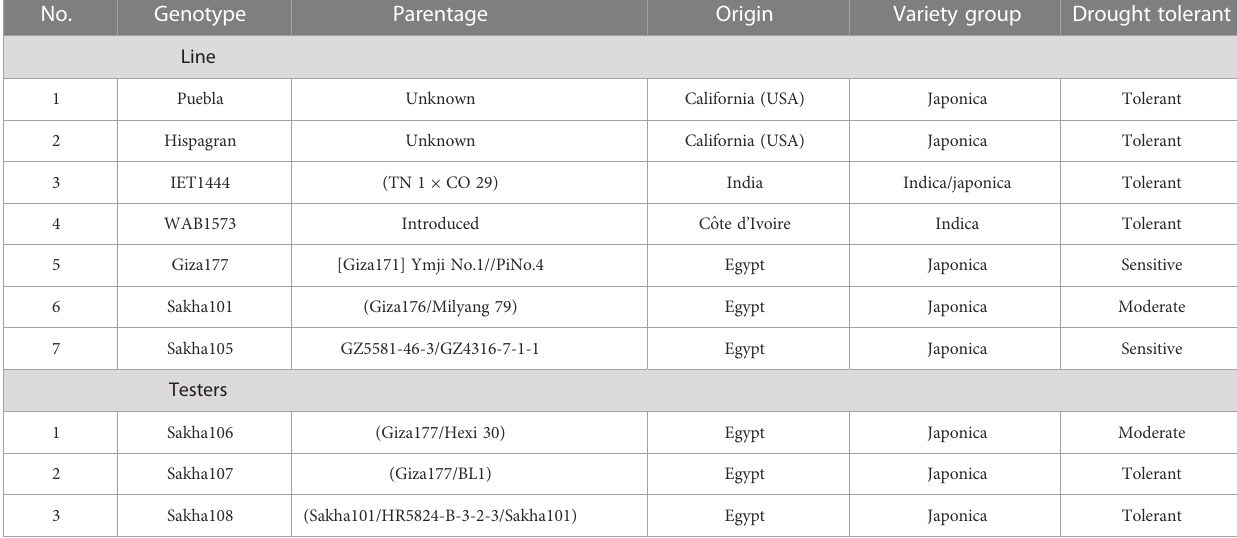
TABLE 1 Origin and main characteristics of the 10 rice genotypes used as parents in the line × tester cross.